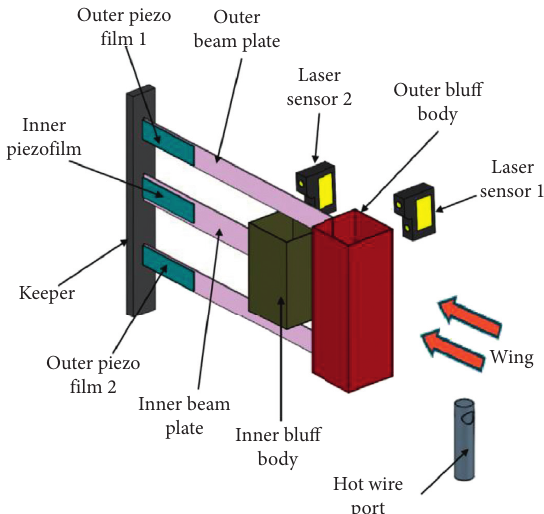
Figure 14: The energy harvester with a nested configuration [118].